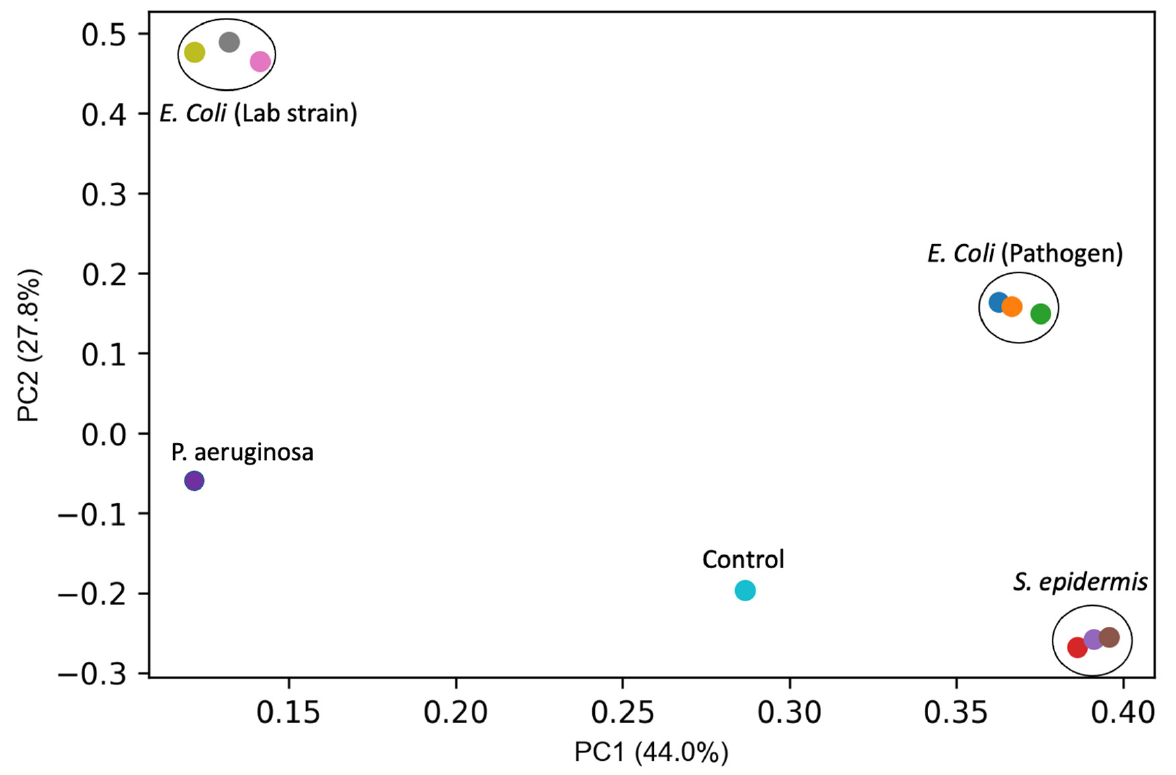
Figure 4. Representative PCA plot illustrating the ability of MIMS to separate the volatile profiles of different bacterial strains and the uninoculated media (control).